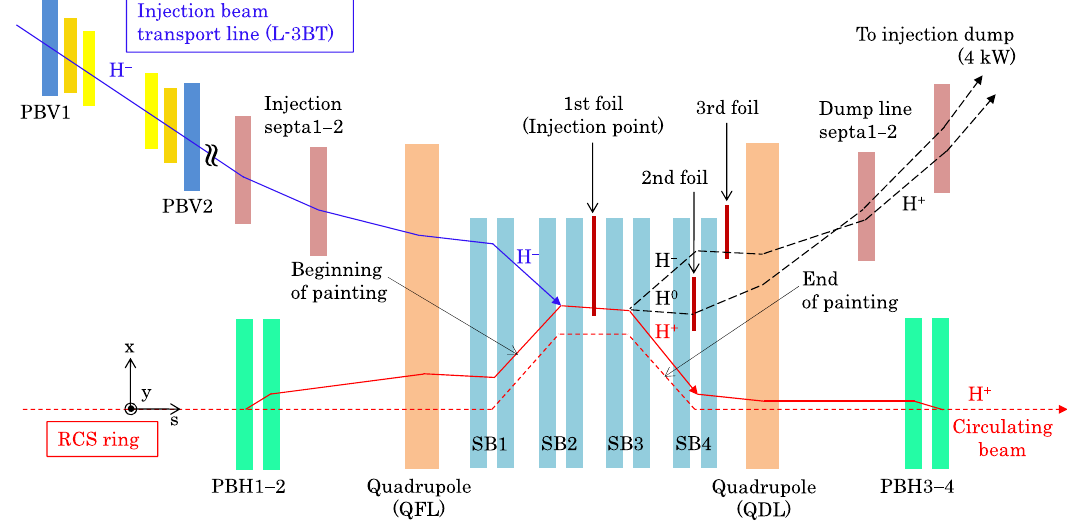
FIG. 3. Schematic view of the injection